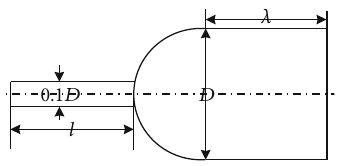
Figure 15: Recti fi er cone con fi